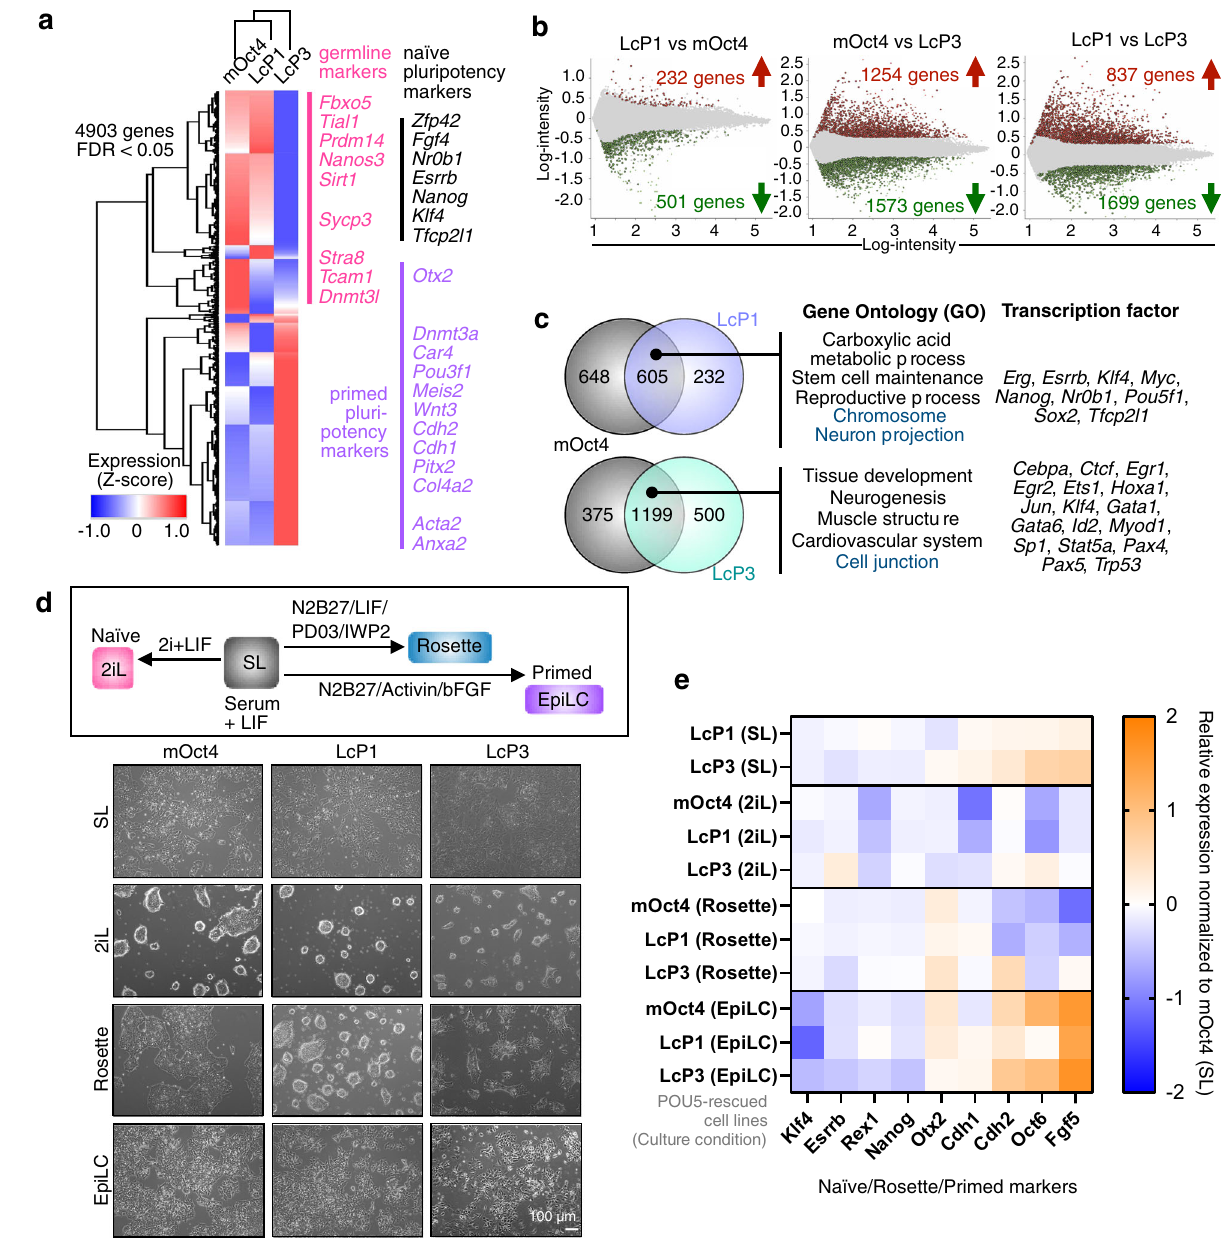
Fig. 5 | Distinct naïve-primed pluripotency phenotypes are supported by sar- copterygian POU5F1 and POU5F3 proteins. a Heatmap illustrating hierarchical clustering of 4903 differentially expressed genes between control (mOct4) and coelacanth POU5 (LcP1 and LcP3) rescued ESC cell lines (fold-change threshold ≥ 2 and FDR ≤ 0.05; n =3 independent biologicalsamples).The normalisedexpression level (z-score) of each gene is shown in three-colour format where red, white, blue indicate high, medium and low gene expression levels, respectively. b Log-ratio plots showing signi fi cantly over-expressed (red) and under-expressed (green) probes,basedontheindicatedpairwisecomparisons(FDR ≤ 0.05).Thesegenelists were further fi ltered based on probes corresponding to uniquely annotated genes and with an absolute fold-change cut-off of 2. c Venn diagrams show a common signatureinLcP1,LcP3andmOct4supportedcells.Inparticular,we fi ndasetof605 over-expressed genes (asigni fi cantmajorityof bothcomparisons)and 1199 under- expressed genes common to both LcP1 and mOct4 supported cells, compared to cells supported by LcP3. GO-term analysis (ShinyGO v0.66: Biological Process and